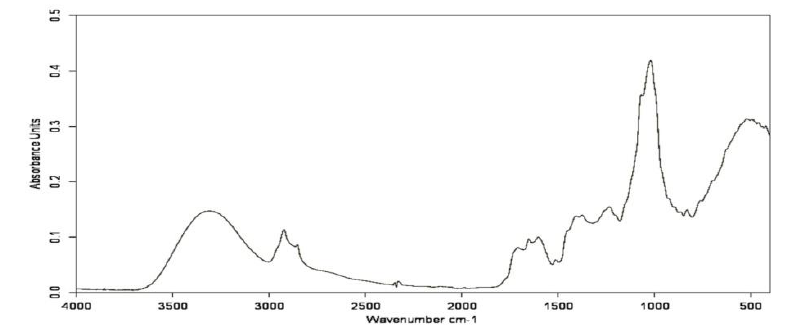
Figure 2. FT-IR spectra of iridoid glycosides fraction from Linaria